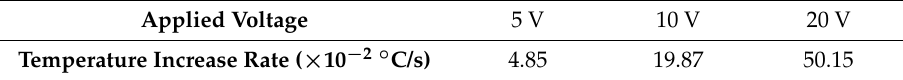
Table 1. Temperature increase rate in the initial linear regions of CNT nanocomposites cured at different voltages.